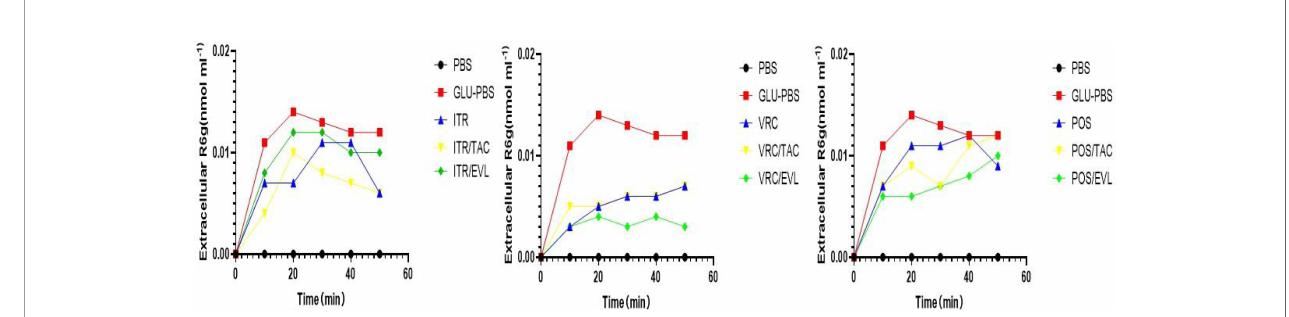
FIGURE 3 | The evaluation of ef fl ux pump function. The effect of TAC combined with azoles on the Rhodamine 6G out fl ow of S. apiospermum (L12E). The extracellular Rhodamine 6G concentration of S. apiospermum (L12E) was determined using spectrophotometry. Energy-dependent Rhodamine 6G ef fl ux was quanti fi ed by adding glucose, azole, and TAC with Rhodamine 6G (10 mM) or Rhodamine 6G (10 mM) in glucose-free PBS and measuring the absorbance of the supernatant at 488 nm. TAC, tacrolimus; EVL, everolimus; ITR, itraconazole; VRC, voriconazole; POS, posaconazole. The values represent the mean and SD of three